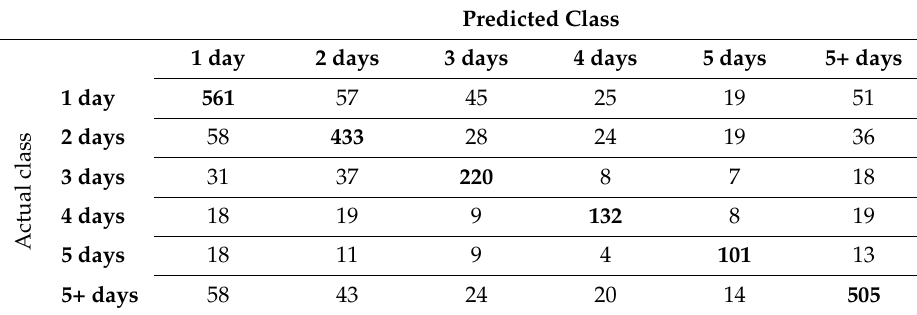
Table 10. Confusion matrix of the best single classifier